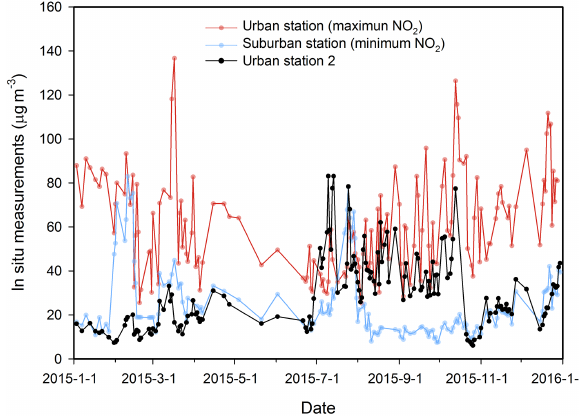
Figure 4. Daily mean surface NO 2 concentrations (µgm − 3 ) of sta- tions located in the city of Xi’an for the year 2015. The data are cal- culated based on the measurements from the air quality monitoring network of MEP. The measurements from the stations correspond- ing to the maximum and minimum annual mean NO 2 concentra- tions are displayed in red and blue, respectively. The measurements from the urban station with lower NO 2 concentrations than subur- ban stations are displayed in